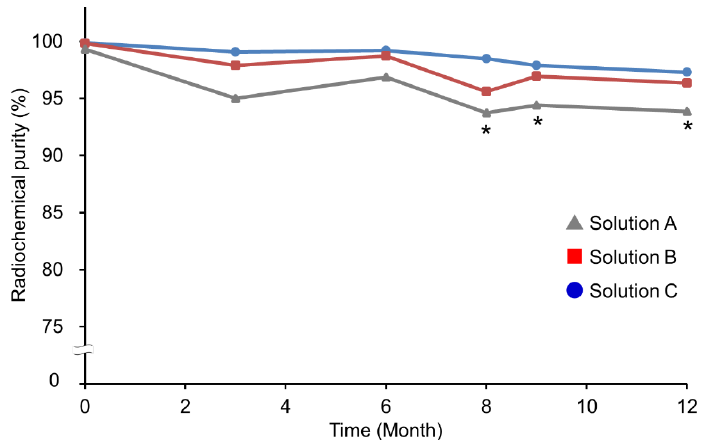
Figure 3. Effect of the stock solutions on the stability of PCTA-NCAB001 conjugates. We prepared radiolabeled 64 Cu-NCAB001 using PCTA-NCAB001 stored at 4 ◦ C for 12 months in Solutions A, B, and C (compositions in Table 1) and compared the radiochemical purity of each condition as the stability index of PCTA-NCAB001; * denotes radiochemical purity < 95%.